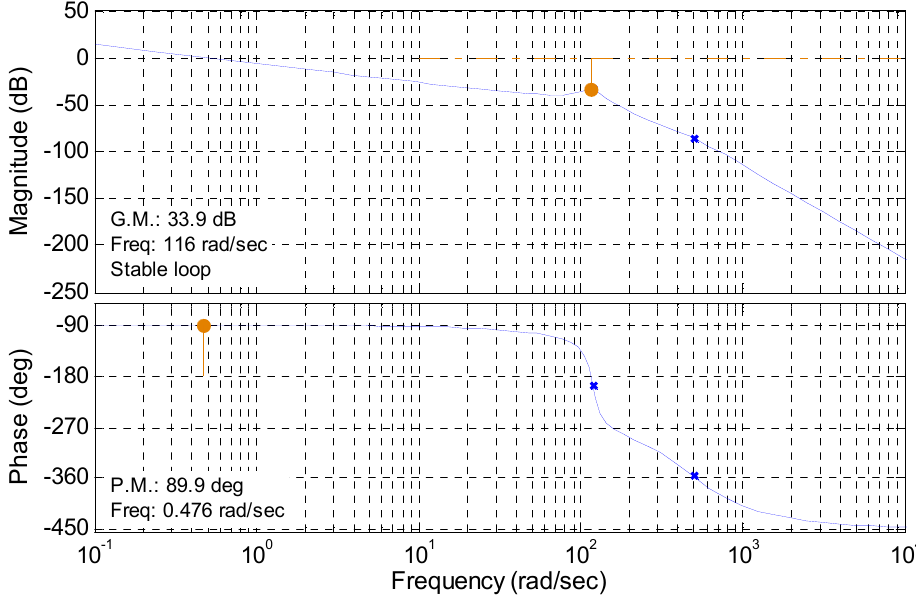
Figure 10. Open-loop Bode diagram of the established